Question: What type of chart is this?
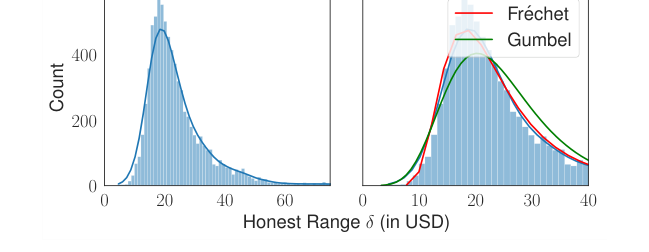
Answer: histogram